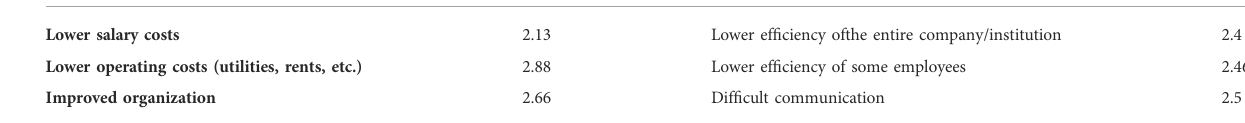
TABLE 5 Advantages and disadvantages for the